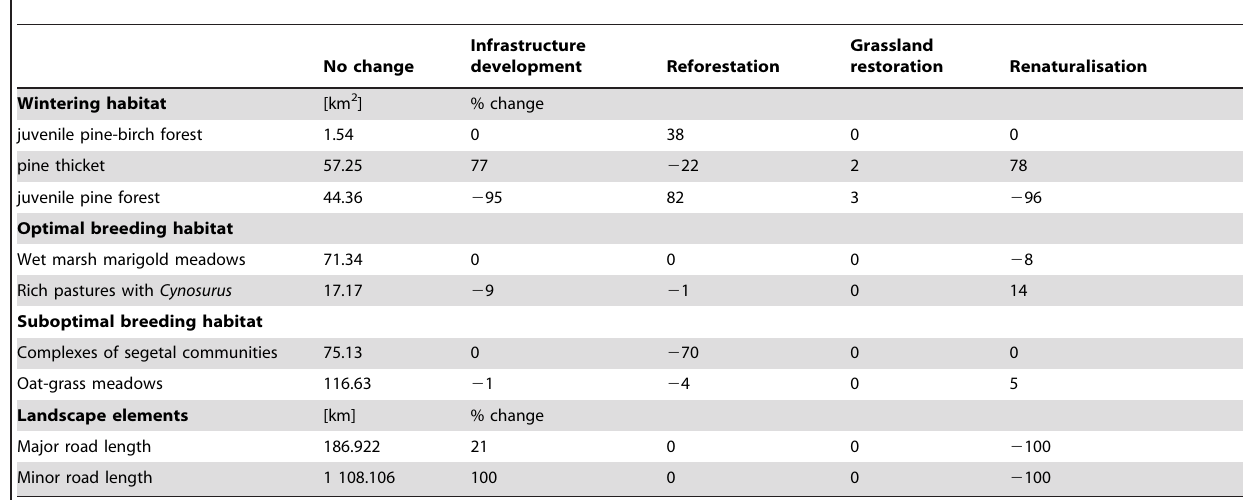
Table 1. Habitat amount and landscape elements relevant for Natterjack toad characterising the four management scenarios, shown as per cent change of ‘‘no change’’